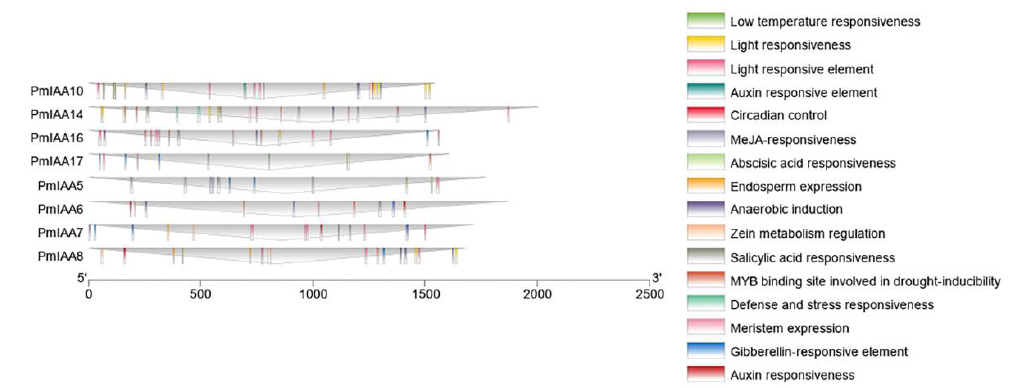
Figure 3. Various cis -elements were identified using the PlantCARE database. The different cis-elements biological terms are shown in different colors.